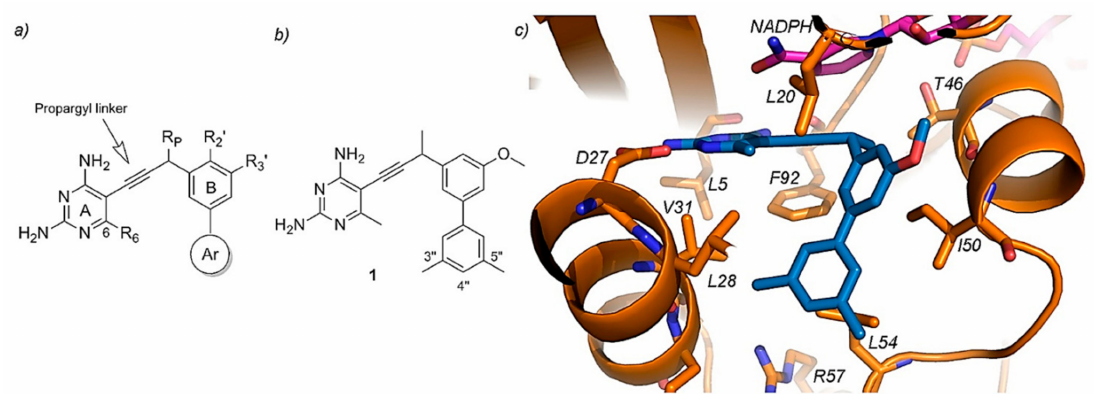
Figure 10. Propargyl-linked antifolates. ( a ) General sca ff old with the diaminopyrimidine ring (A), phenyl ring (B) and aryl ring (Ar) along with possible positions for substitutions (R6, RP, R29 and R39). ( b ) A concrete example of a propargyl-linked antifolate, a biphenyl one, with labeled atom positions (compound 1). ( c ) Active site of a resistant DHFR, showing active site residues (orange), NADPH (magenta) and compound 1 (blue). Reproduced from Viswanathan et al